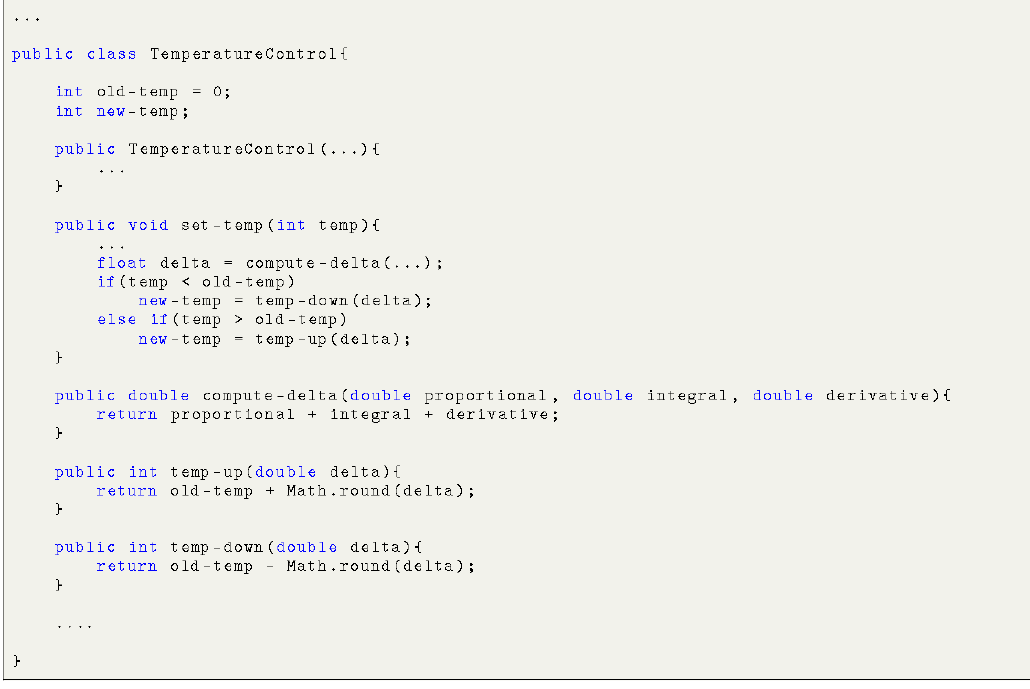
Figure 3. An example implementation (AppImpl) of a temperature